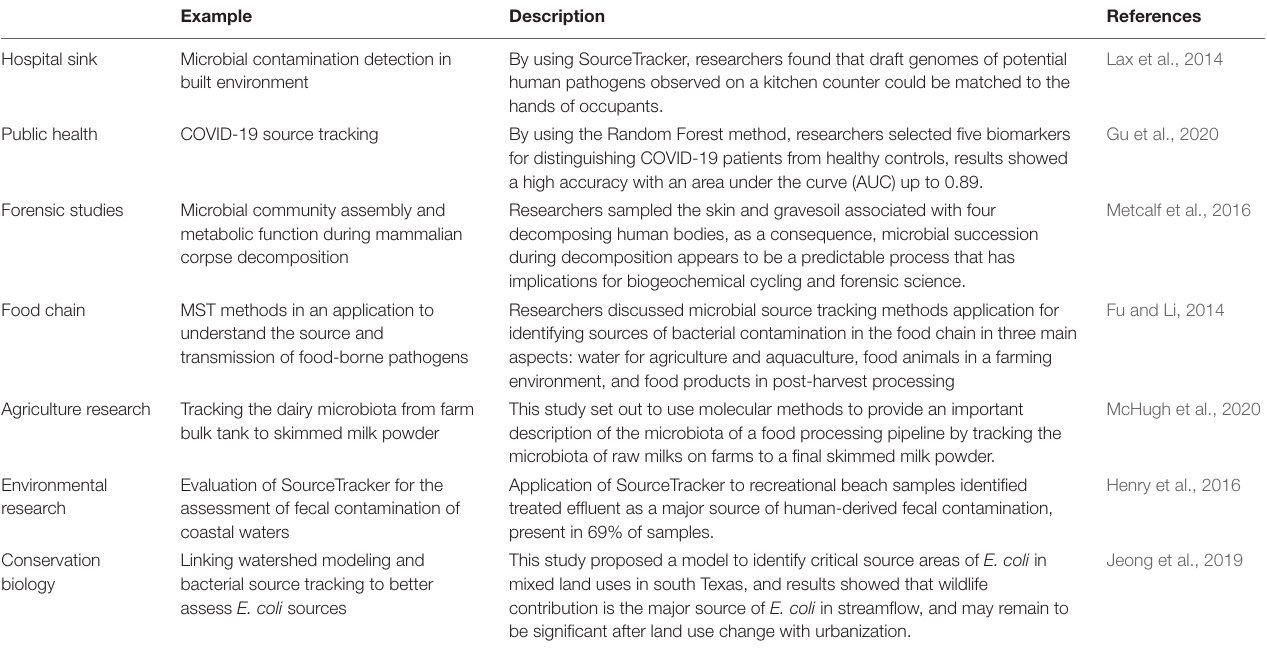
TABLE 4 | Current applications of microbiome sample comparison and